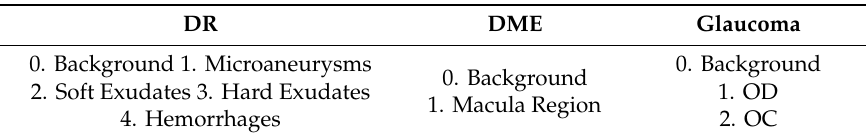
Table 2. Classes of eye